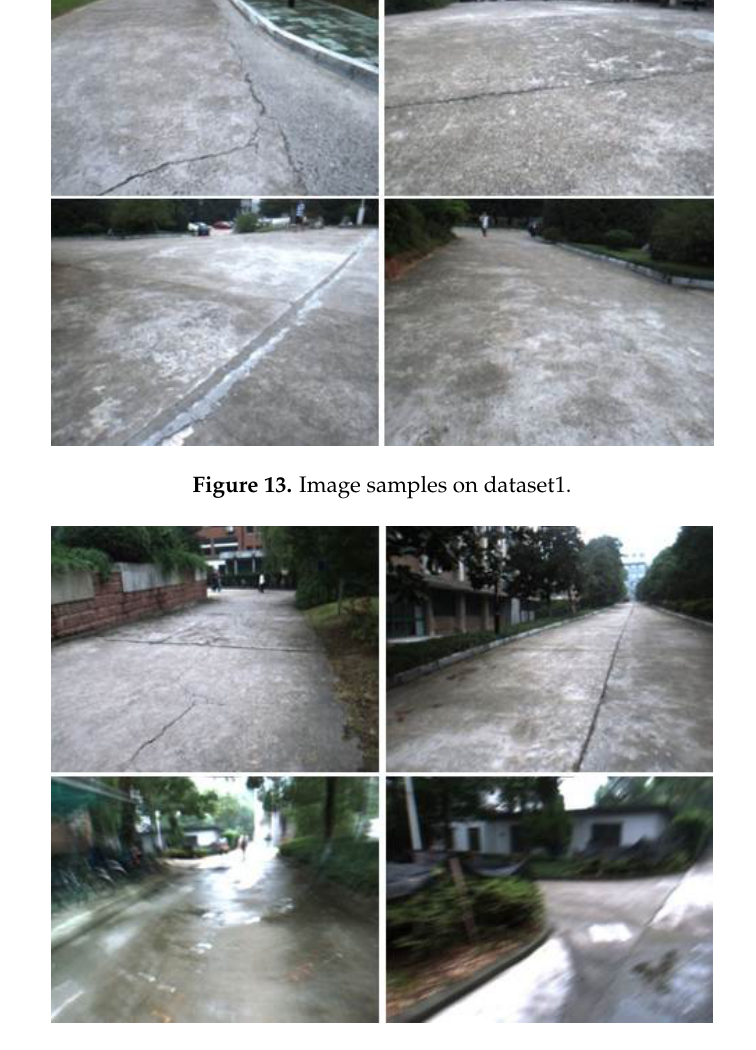
Figure 14. Image samples on